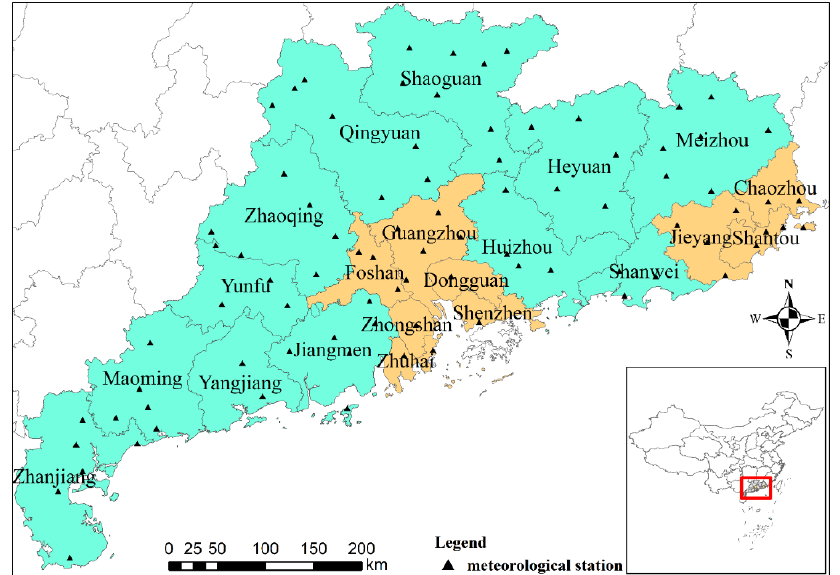
Figure 1. Location of the study region and meteorological station. Table 1. The grading standard of THI , WEI , ICL , and CCI